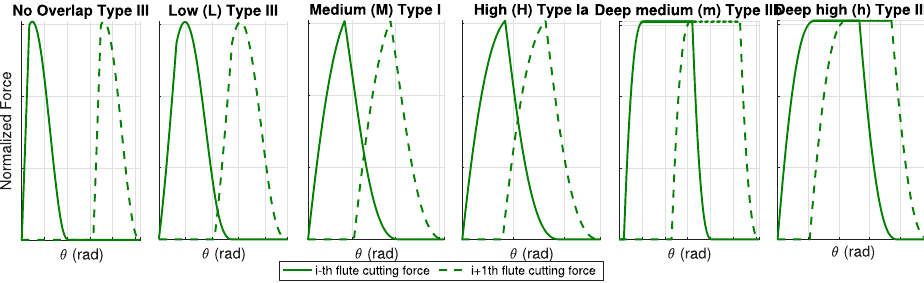
Figure 5. Example of different degrees of overlap for different types of single flute F shape in down- milling.